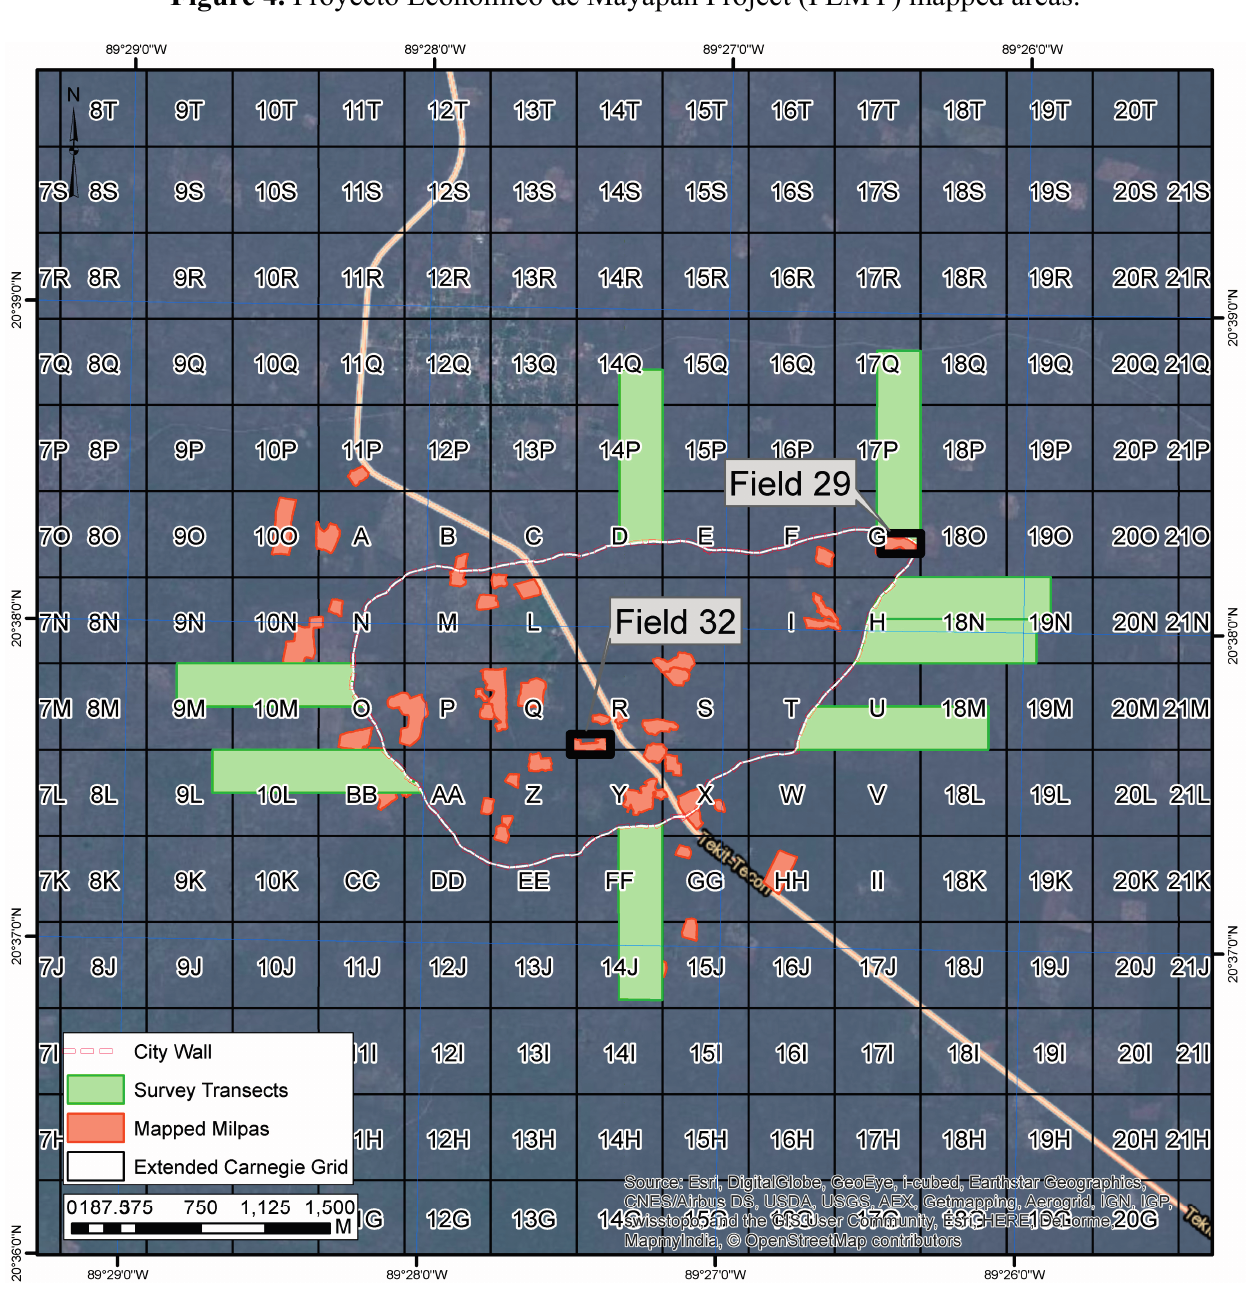
Figure 4. Proyecto Económico de Mayapán Project (PEMY) mapped